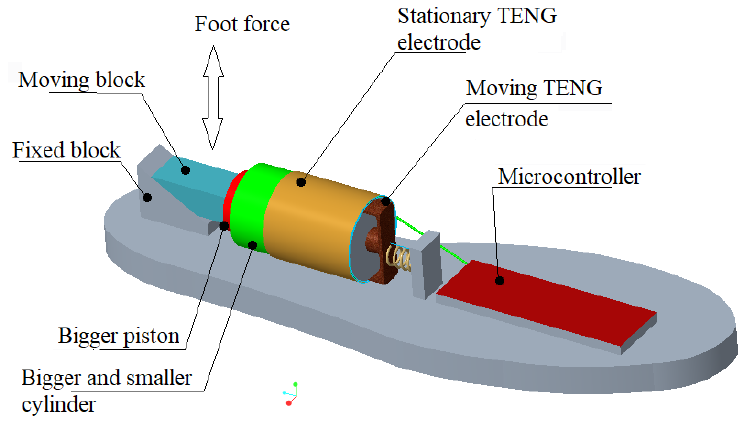
Figure 21. Creo model of the in ‐ shoe sensor.